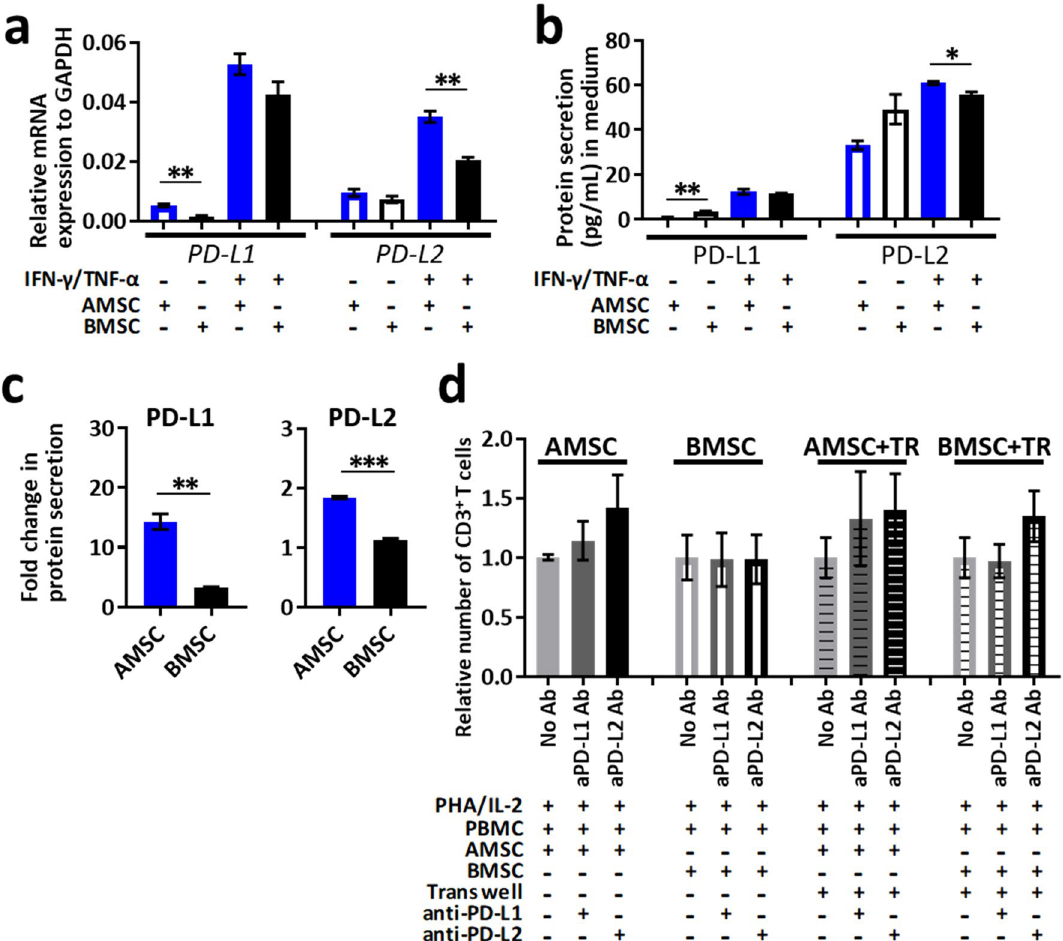
Figure 5. PD-L1 and PD-L2 upregulation in AMSC stimulated with IFN-γ/TNF-α associated with inhibition of T cell proliferation in PHA/IL-2 stimulated PBMC in vitro. ( a ‒ c ) AMSC or BMSC were stimulated with IFN-γ/ TNF-α for 24 h. ( a ) Gene expressions of PD-L1 and PD-L2 in AMSC or BMSC by real-time PCR. ( b ) Protein concentrations of PD-L1 and PD-L2 in culture medium by ELISA. ( c ) Fold changes in PD-L1 and PD-L2 secretion calculated as the ratio of values in cultures with and without stimulation. ( d ) PBMC were stimulated with 4 μg/mL PHA and 100 U/mL IL-2 for 72 h with or without AMSC or BMSC in the presence of anti-human PD-L1 or PD-L2 antibody (Ab) at a PBMC/MSC ratio of 10:1. For indirect coculture experiments, a TR system comprising upper wells with PBMC and lower wells with MSC was used. Relative number of CD3 + T cells shown as 1 for No Ab in each coculture condition. Data from one of two independent experiments ( a ‒ c ) and combined data from more than three independent experiments ( d ) are presented as mean ± SEM. * P < 0.05, ** P < 0.01, *** P < receptor associated with chronic inflammatory diseases including hepatitis C virus infection 37,38 . Their concen- trations increased in direct PBMC–BMSC coculture, but were markedly suppressed in direct PBMC–AMSC coculture. Because these chemokines induce the migration and activation of leukocytes 39,40 , AMSC might have the ability to decrease proinflammatory chemokines and lead to calm inflammation by contacting stimulated PBMC. On the other hand, concentrations of some proinflammatory cytokines and chemokines were elevated in PBMC–MSC coculture medium. Previously, MSC derived from bone marrow, umbilical cord, adipose tissue, and Wharton’s jelly were reported to increase IL-6 and IL-8 concentrations in coculture with PBMC 25 . These changes were similar in that they were partially due to allogeneic response of PBMC versus MSC and should be carefully monitored to avoid the promoting GVHD during clinical setting. Further, concentration of anti-inflammatory cytokine IL-10 only increased in direct PBMC–AMSC cocul- ture, but not in PBMC–BMSC coculture and indirect coculture. Because Treg populations were not different, AMSC were presumed to be involved in high functionality of Treg. Notably, FOXP3 is expressed not only in Treg but also in naïve CD4 + T cells stimulated by mitogens 41 . Additionally, IL-10 concentrations were elevated in mitogen-stimulated PBMC directly cocultured with AMSC in vitro but not in xeno-GVHD mice in this study. Therefore, the differences between xenogeneic and allogenic response in the context of cell–cell contact warrant careful consideration.